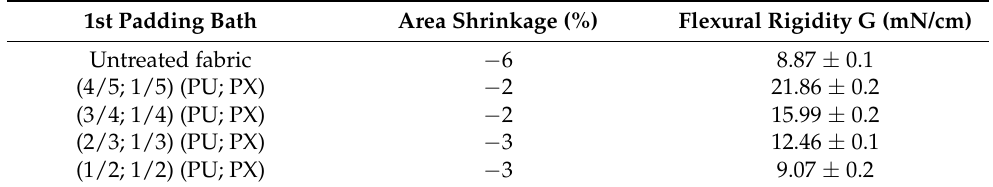
Table 6. Area shrinkage and flexural rigidity results of the samples treated with the 1st padding bath. 1st Padding Bath Area Shrinkage (%) Flexural Rigidity G (mN/cm)